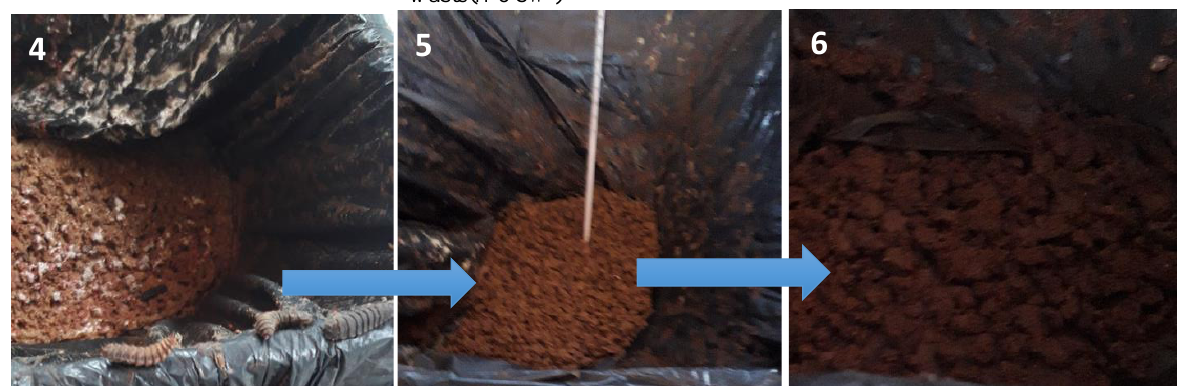
All reagents used for heavy metal analysis were analyt- ical grade. The heavy metals such as Iron (Fe), Magne- sium (Mg), Calcium (Ca) and Aluminium (Al) were